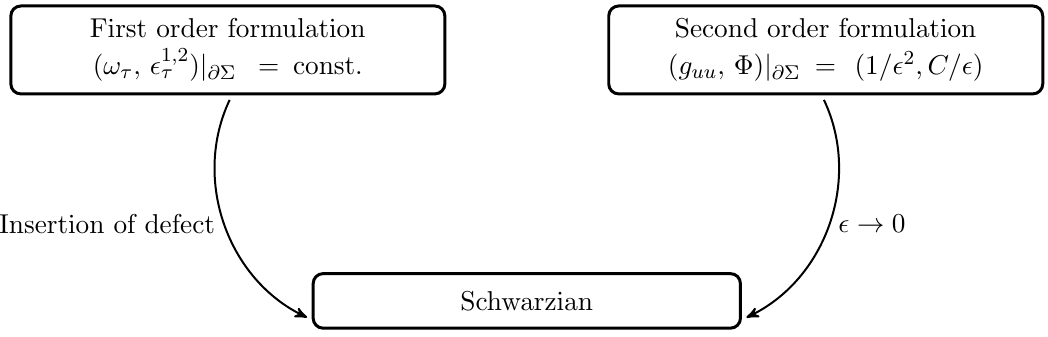
Figure 1 . Schematic representation showing that the dynamics on the defect in the gauge theory is the same as that in the Schwarzian theory, which in turn describes the boundary degrees of freedom of